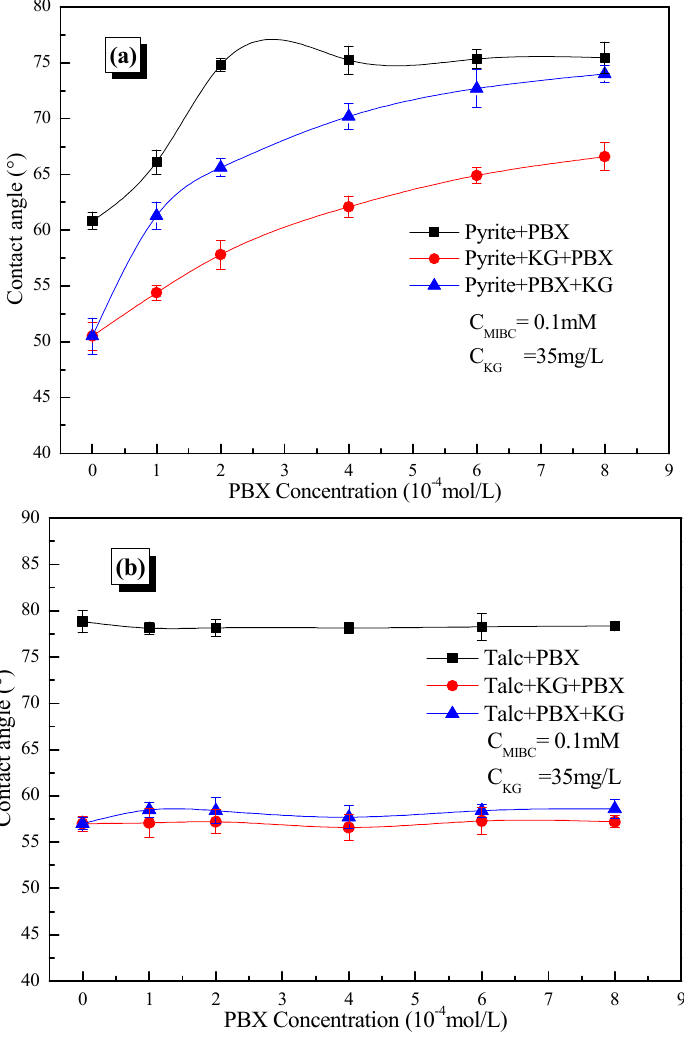
Figure 7. Effect of the KG/PBX addition order on the flotation recovery of pyrite ( a ) and talc ( b ).